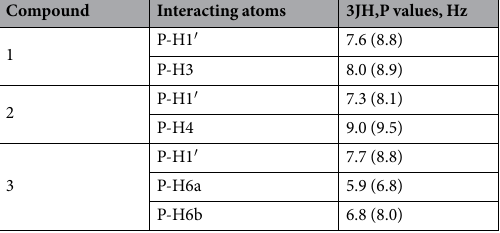
Table 6. Experimental and calculated (in parenthesis) averaged three-bond coupling constants 3JH,P (Hz) in the 1 H NMR spectra of compounds 1–3